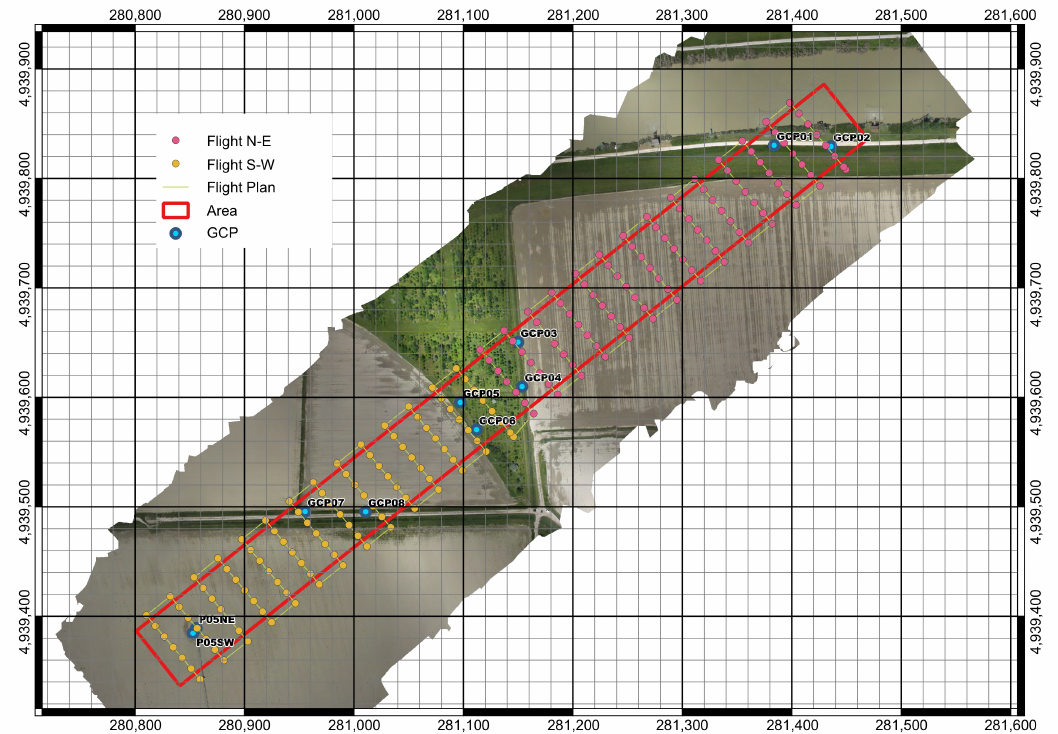
Figure 3. Flight planning taking into account the described restrictions and constraints. Grid coordi- nates are ETRS89/UTM zone 33N (EPSG:25833). The RGB orthomosaic was obtained from the first experimental